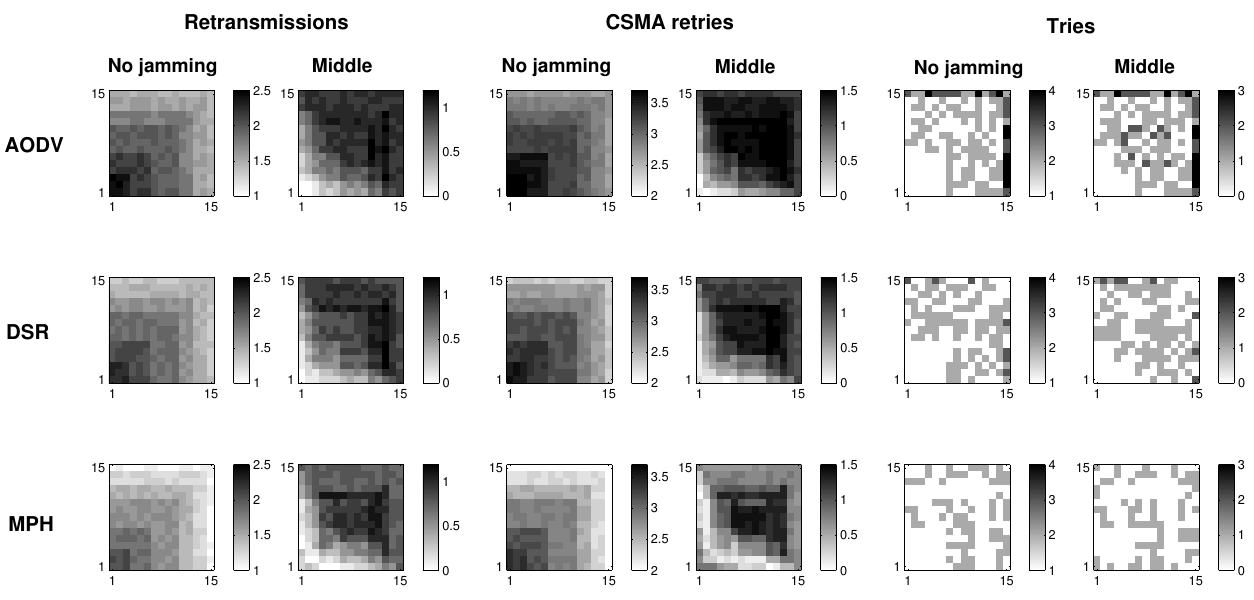
Figure 10. 2D representation of the average retransmissions, CSMA retries and tries in the no jamming case and the difference between the values in the reactive and no jamming cases when the jammer node is in the middle of the topology. Table 4. Sum of the values of differences for Figure 10. Position of the Jammer Node = Middle Retransmissions CSMA